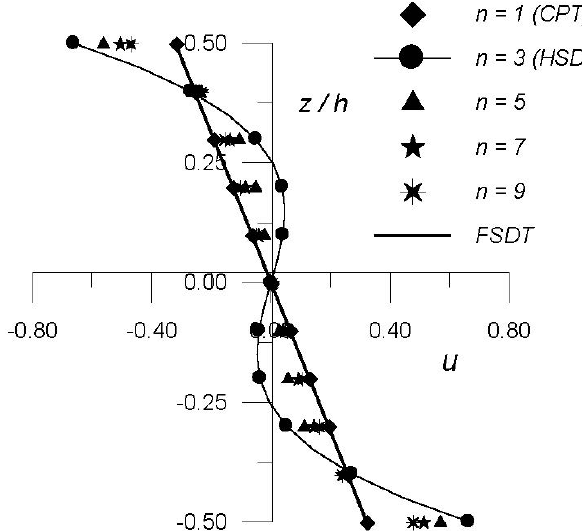
Figure 10: Through thickness distribution of in-plane displacement ( ¯ u ) for simply supported three layered (0 ∘ /90 ∘ /0 ∘ ) symmetrically laminated composite plates with a / h = 4 and E 1 / E 2 = 40